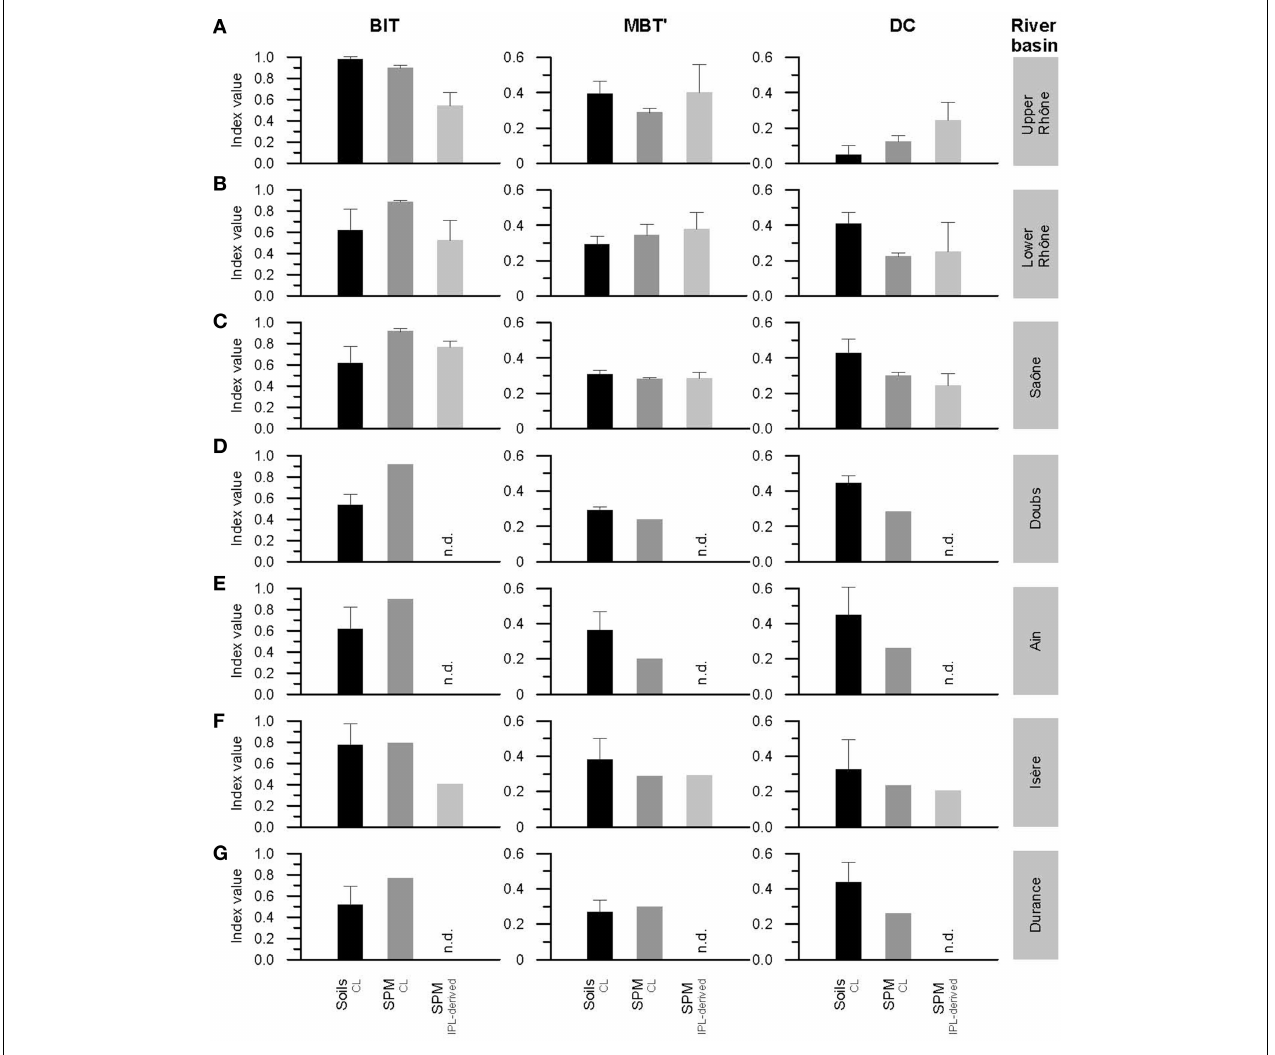
basins of Saône (C), Doubs (D), Ain (E), Isère (F), and Durance (G). Note that “n.d.” indicates no data available. Letters indicate statistically significant groups of data ( p < 0 . 05